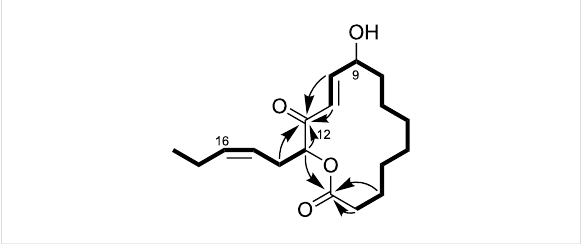
The stereogenic center C13 constitutes an α -acyloxy ketone moiety and deacylation catalyzed by a base may result in the loss of chirality because of epimerization [12]. To circumvent this problem, we initially attempted to protect the ketone group prior to chemical conversion (Scheme 1). Compound 1 was acetylated (Supporting Information File 1) and subjected to protection as 1,3-dithiane [13] or 1,4-dinitrophenylhydrazone [14]; however, neither of them resulted in the desired products. Then a strategy without protection was explored (Scheme